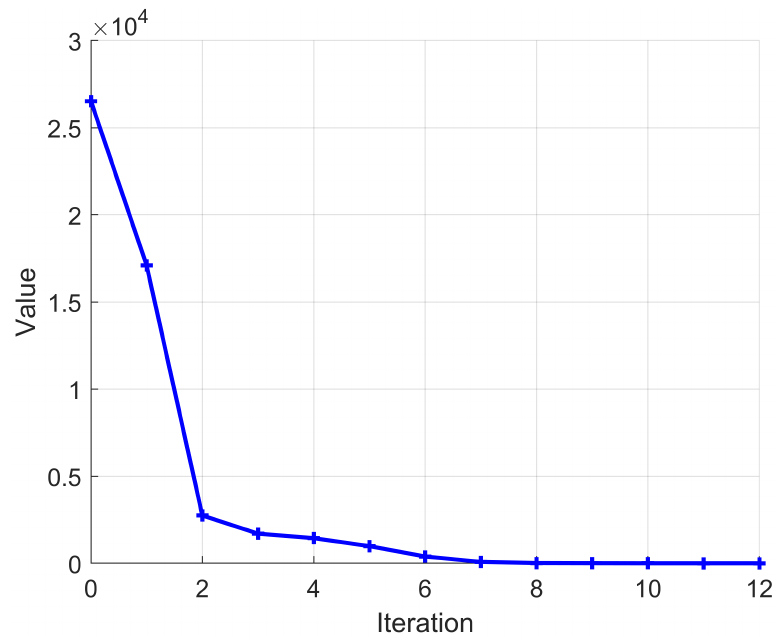
Figure 10. The sum of squared error over each step of the iteration during the calibration